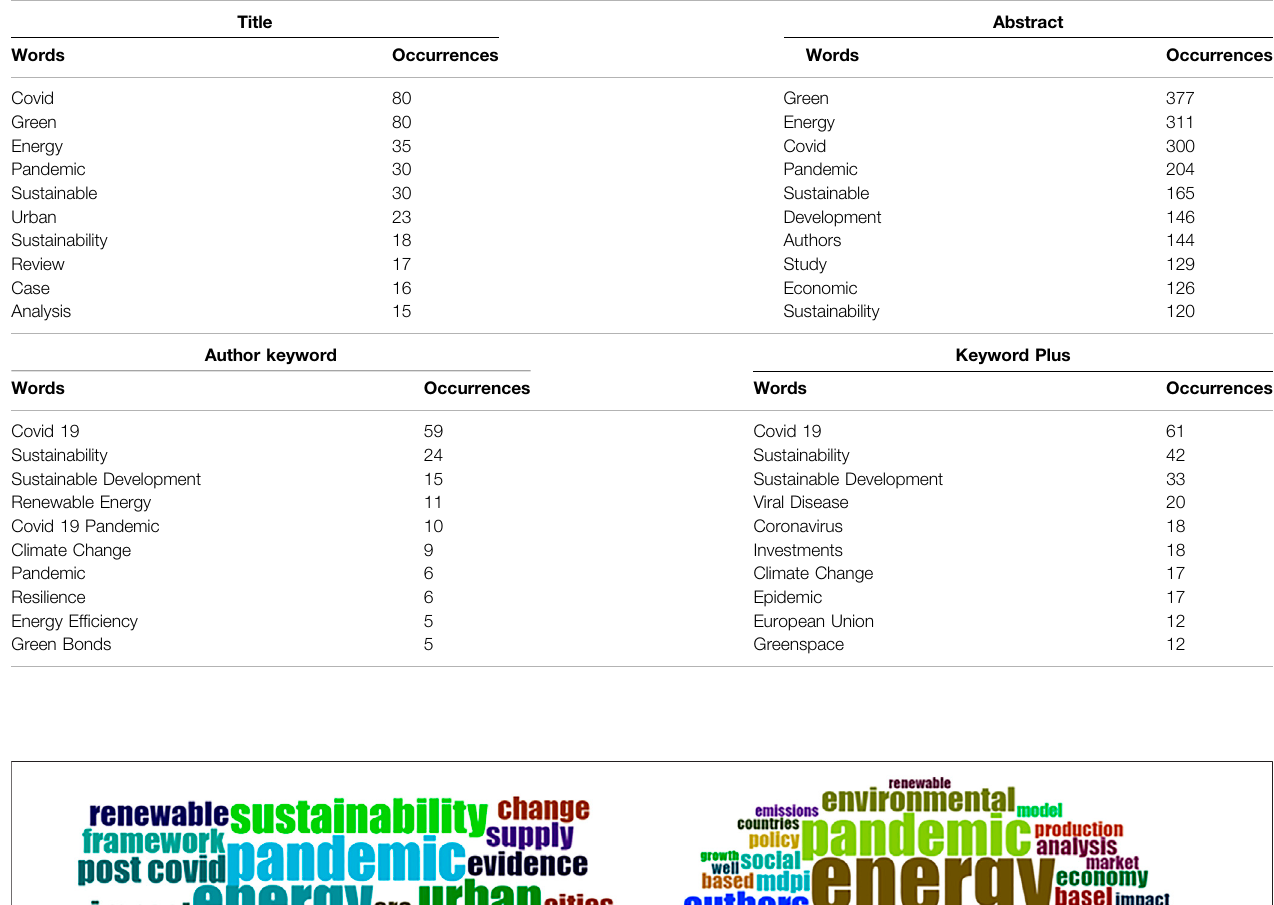
TABLE 11 | Distribution of publications on green energy ef fi ciency by keyword.